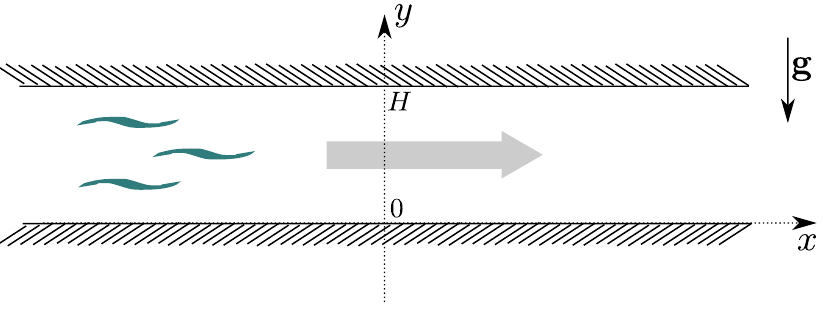
Figure 1. A sketch of the channel with adiabatic